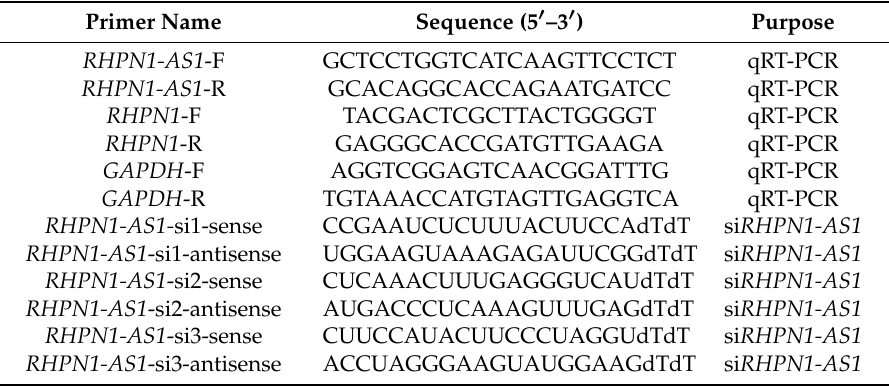
Table 1. Primers and siRNA used in this